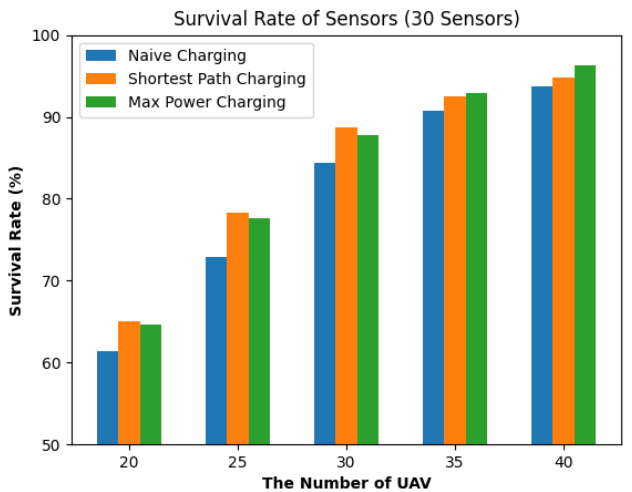
Figure 3. Impact of different algorithms and number of UAVs on the survival rate of sensors.